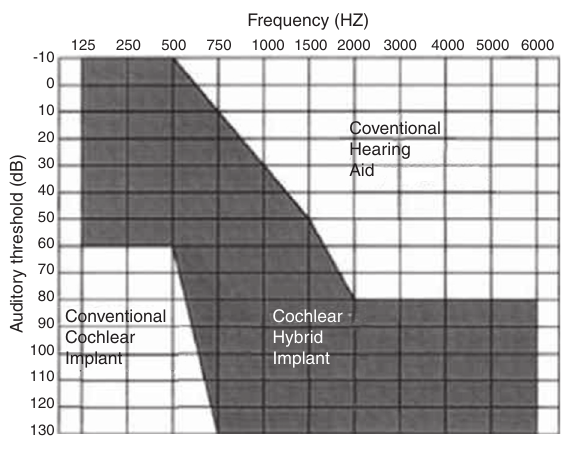
Illustrative graphic of the audiometric pattern expected in hybrid-implant